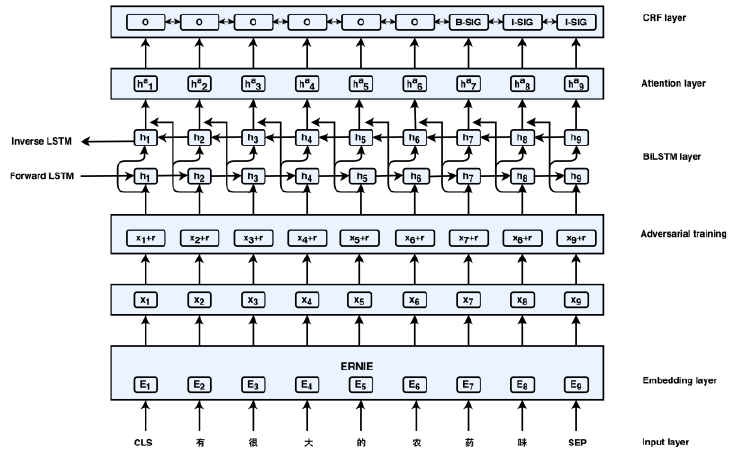
Figure 2. ERNIE-Adv-BiLSTM-Att-CRF model framework for named entity recognition. The model consists mainly of an input layer, an embedding layer, adversarial training, BiLSTM-CRF and self-attention.